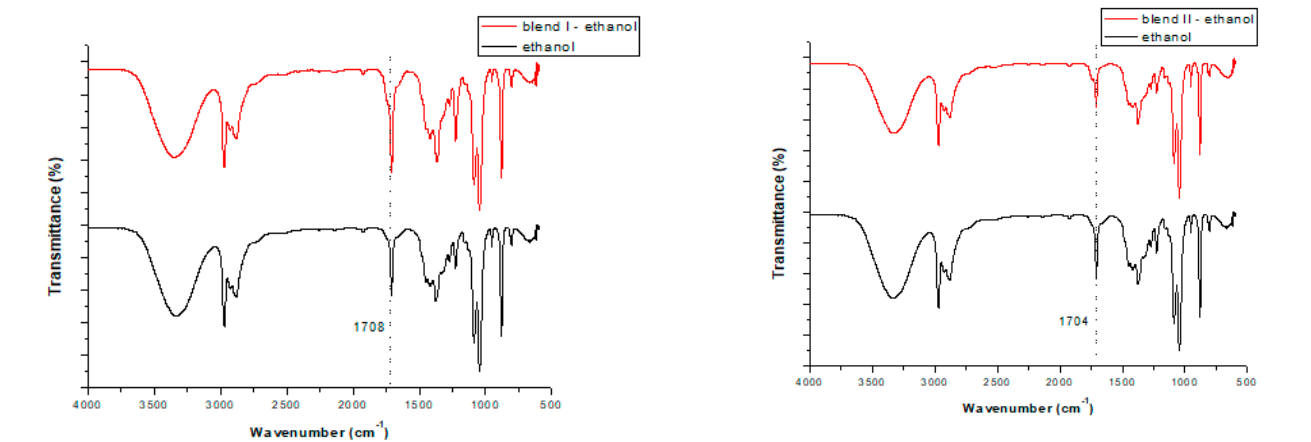
Figure 5. FTIR spectra of the pure ethanol and ethanol received after applying 6 h soxhlet extraction for blend I (left) and blend II (right).